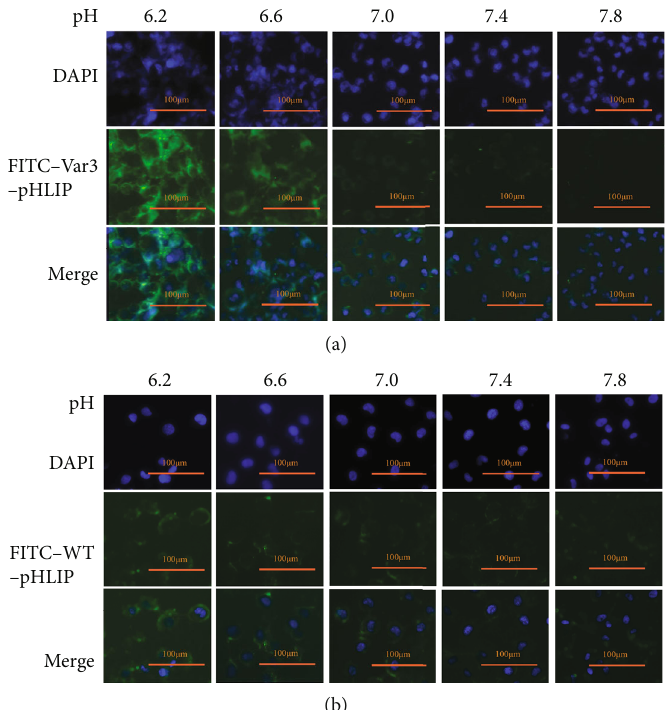
Figure 1: Fluorescence imaging and cell viability at di ff erent pH values. Fluorescence imaging ( × 100) demonstrated that the ability of (a) FITC-labeled variant 3 pH-low insertion peptide (var3-pHLIP) and (b) FITC-labeled wild-type (WT)-pHLIP to bind to MDA-MB-231 cell line increased with the decrease in pH (7.8, 7.4, 7.0, 6.6, and 6.2).